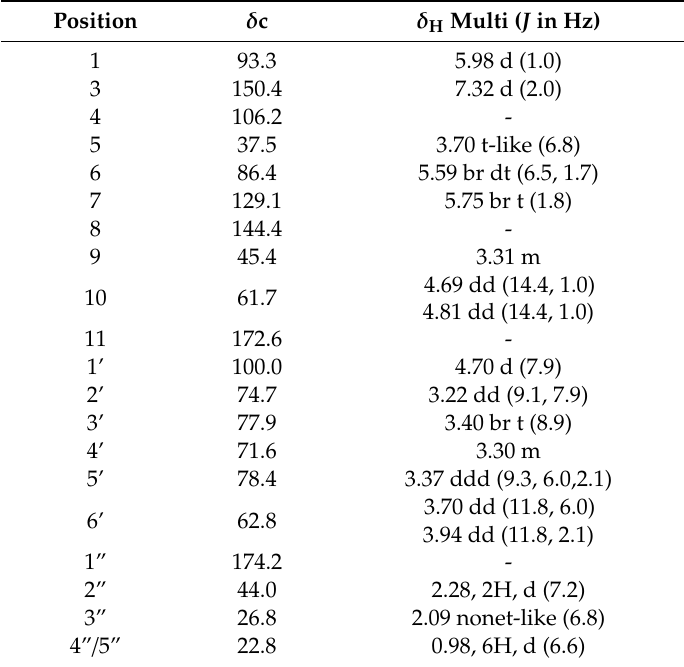
Table 1. The 13 C and 1 H-NMR spectroscopic data for 1